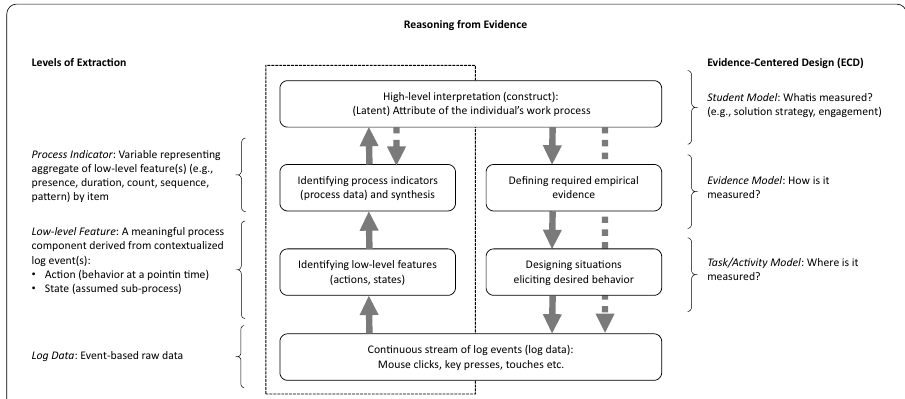
Fig. 2 Assessment as reasoning from evidence derived from log